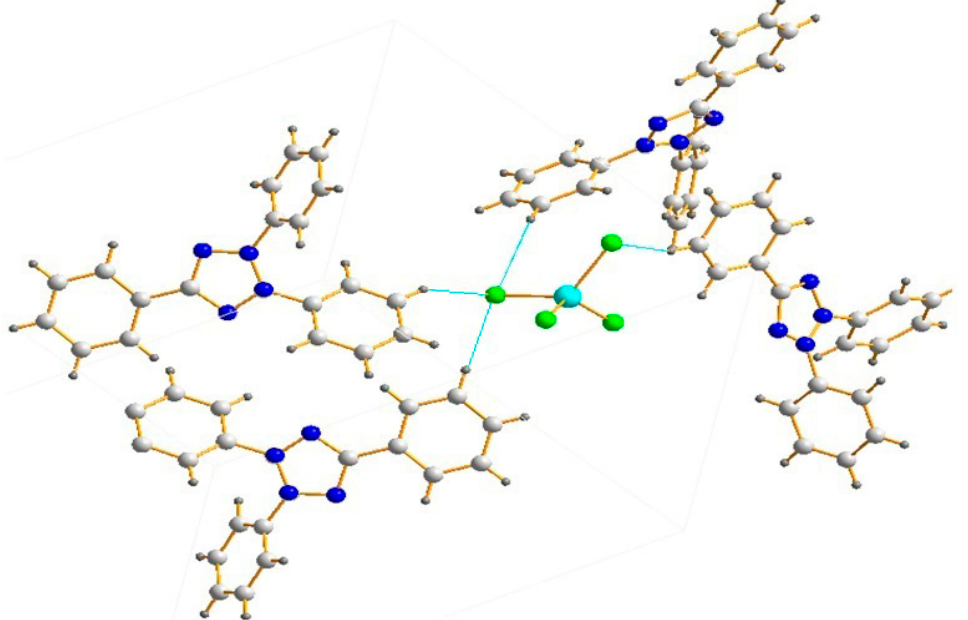
Figure 1. Structure of the complex (2,3,5-TPhTz) 2 [CuCl 4 ] [44].